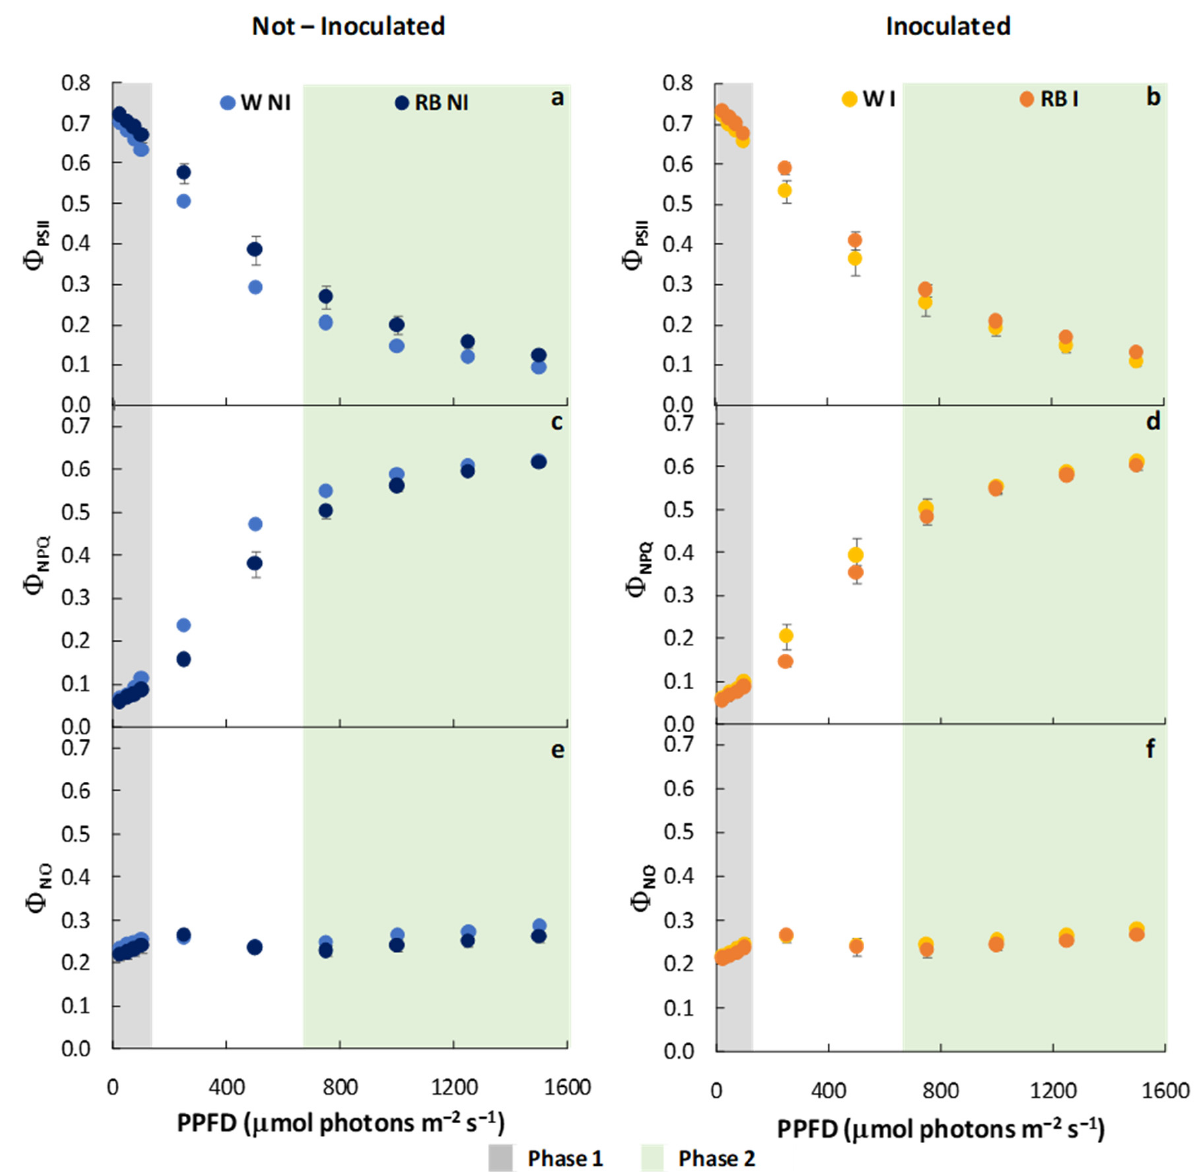
Figure 3. Effective quantum yield of PSII, Φ PSII ( a , b ); regulated energy dissipation of PSII, Φ NPQ ( c , d ); not-regulated energy dissipation of PSII, Φ NO ( e , f ) of not-inoculated (NI) and inoculated (I) spinach plants grown under W and RB light regimes. Data are means ± standard error (n = 5). phase 1 (grey) and phase 2 (green).